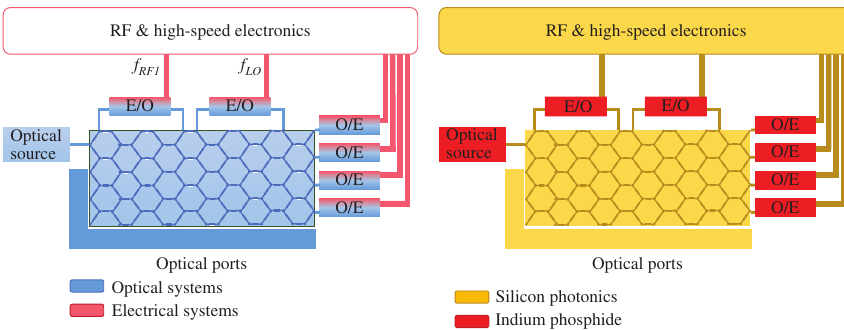
Figure 3: High level configuration of a general photonic integrated processor including passive and active components. (Left) General photonic integrated processor architecture and (right) candidate fabrication platforms for each subsystem (after Ref.